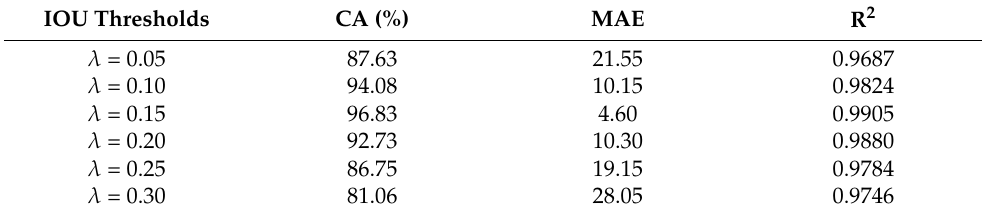
Table 5. Results when the model uses different IoU thresholds for detection. IOU Thresholds CA (%) MAE R 2 λ = 0.05 87.63 21.55 0.9687 λ = 0.10 94.08 10.15 0.9824 λ = 0.15 96.83 4.60 0.9905 λ = 0.20 92.73 10.30 0.9880 λ = 0.25